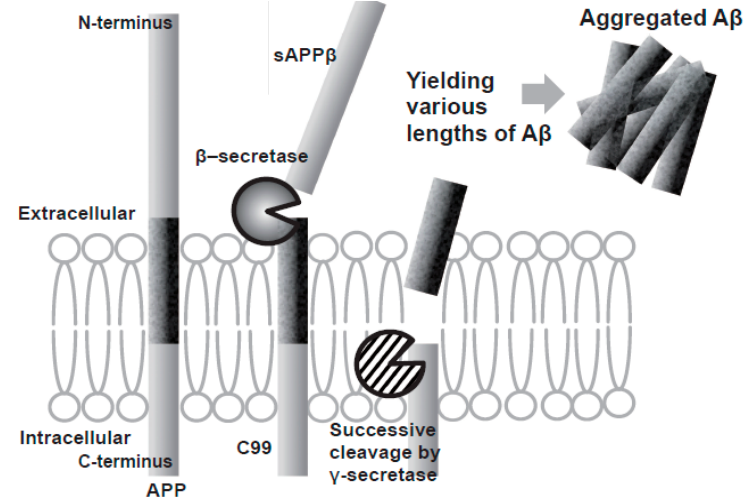
Figure 3. Scheme of the production of A β by the two step sequential cleavage of APP by β -secretase and γ -secretase. Adapted from [15].